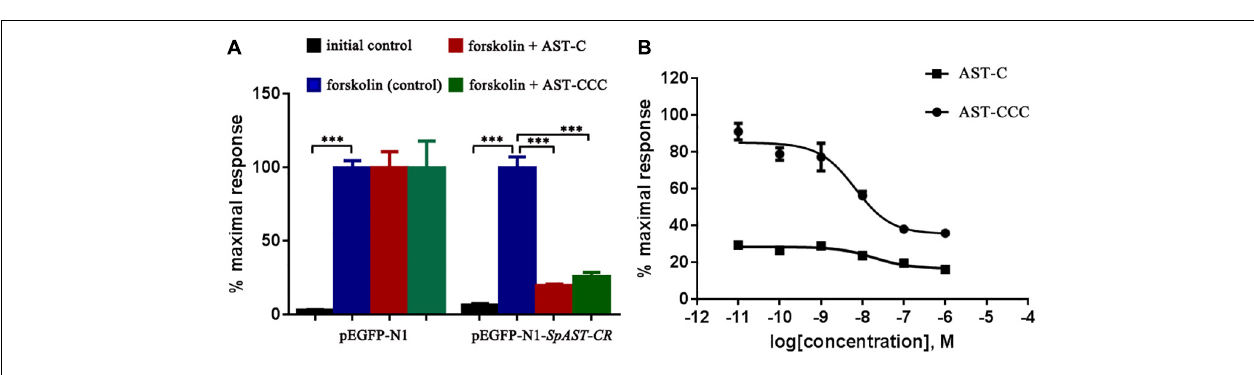
FIGURE 2 | Functional characterization of Scypa AST-CR in HEK293T cells in vitro. (A) Scypa AST-CR was activated after stimulation with Scypa AST-C or Scypa AST-CCC at concentration of 10 − 6 M, resulting in a significant inhibition of forskolin-stimulated luciferase activity (*** P < 0.0001). (B) Receptor activation following stimulation by different concentrations of Scypa AST-C and Scypa AST-CCC peptides was determined by monitoring intracellular cAMP levels. Curves were obtained by fitting the data using non-linear regression analysis in the GraphPad Prism